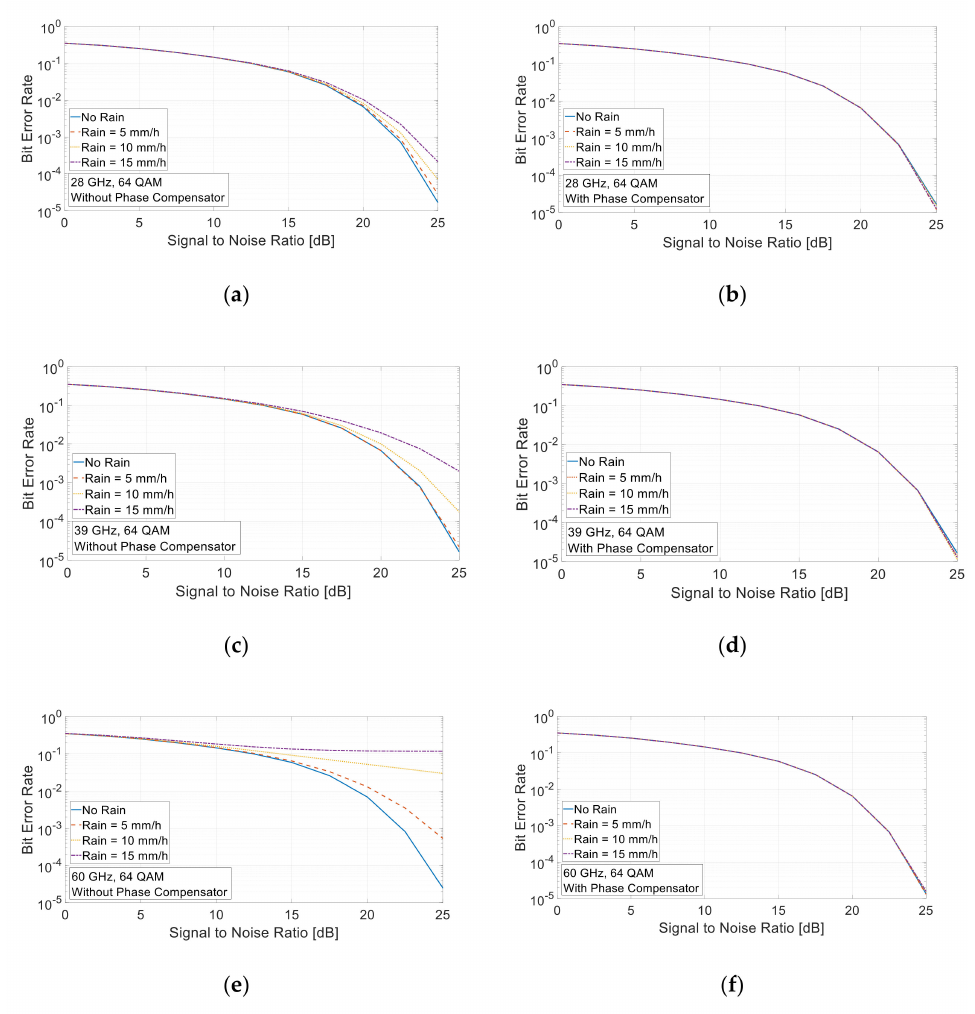
Figure 5. Bit Error Rate (BER) Performance of 64 QAM and e ff ect of Phase Distortion Compensator on it at carrier frequencies of ( a , b ) 28, ( c , d ) 39, and ( e , f ) 60 GHz for 200 m wireless link in di ff erent rainfall